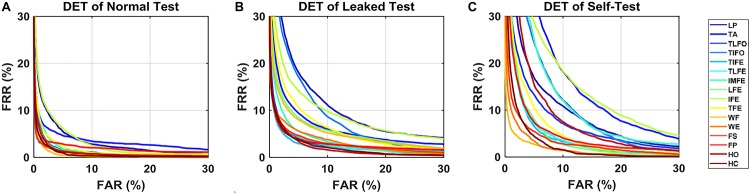
DET curves for each gesture in three scenarios: (A) normal test, (B) leaking test, and (C) self-test. The data are averaged across the subjects.